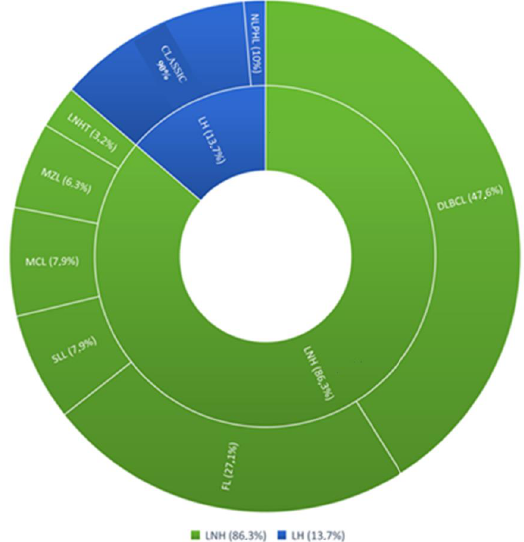
Figure 1. Clinical case study. NHL (non-Hodgkin ’ s lymphoma); subtypes: DLBCL (diffuse large B cell lymphoma), FL (follicular lymphoma), SLL (small lymphocytic lymphoma), MCL (mantle cell lymphoma), MZL (marginal zone lymphoma), LNH T (non-Hodgkin T cell lymphoma). HL (Hodgkin lymphoma); subtypes: CHL (classical Hodgkin lymphoma), NLPHL (nodular lymphocyte predominant Hodgkin lymphoma).